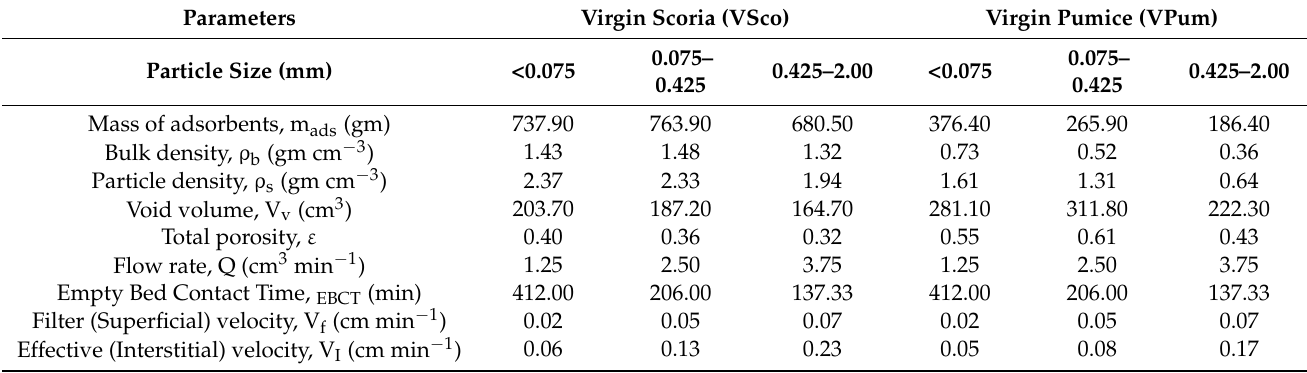
Table 1. Material properties and experimental